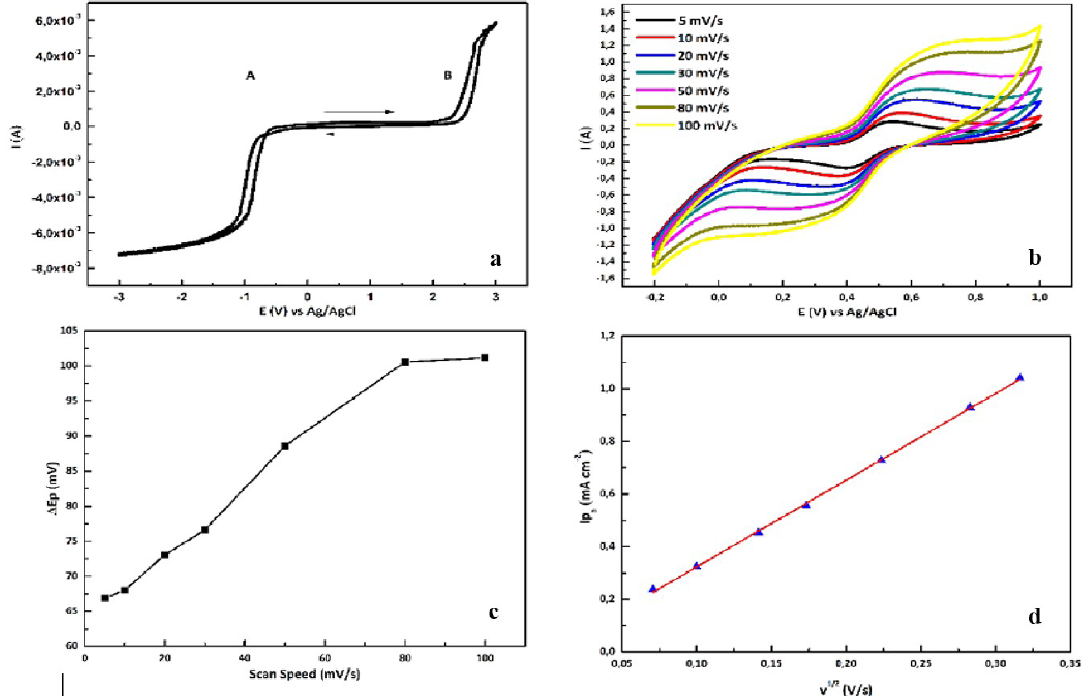
SO 0.5 mol L -1 using a potential 2 4 Fe(CN) in 4 6 Fe(CN) in H SO 0.5 mol L -1 ; (d) 4 6 2 4